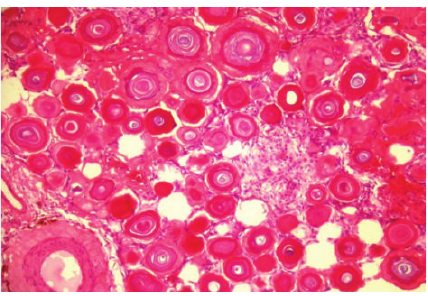
Figure2:Microscopicappearanceofthesurgicalspecimen.Numer- ous psammomatous bodies admixed among fusiform meningothe- lial cells (H&E).